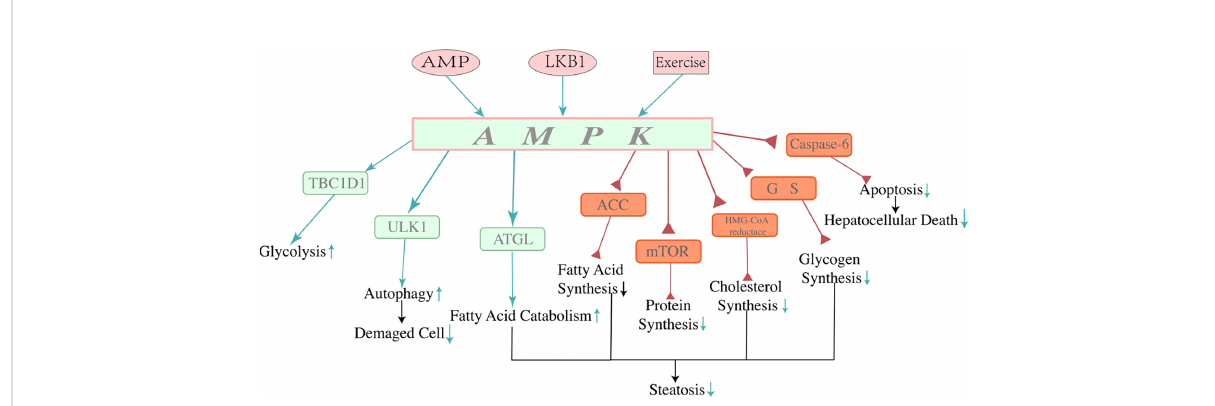
FIGURE 2 Mechanisms of adenosine 5 ′ -monophosphate-activated protein kinase. AMPK is a crucial controller of energy metabolism. AMP, LKB1, and exercise can activate AMPK directly or indirectly. AMPK regulates protein, fat, and carbohydrate metabolism. Activation of AMPK restrains lipogenesis, promoting fatty acid catabolism in the liver through multiple mechanisms of energy regulation, thus decreasing hepatocyte steatosis and contributing to the consumption of the energy of the whole body. Due to its function in energy regulation, activation of AMPK reduces lipid accumulation by reducing lipid synthesis and stimulating lipid catabolism, which alleviated hepatocyte steatosis and showed a bene fi cial effect on NAFLD. In addition, the function of AMPK reducing hepatocyte apoptosis by inhibiting activation of caspase-6 has been found recently, which may indicate a new approach to improve NAFLD. Three pink icons at the top of the image are approaches to activating AMPK. The green arrows represent the positive effect, and the red triangles represent the negative effect. NAFLD, non-alcoholic fatty liver